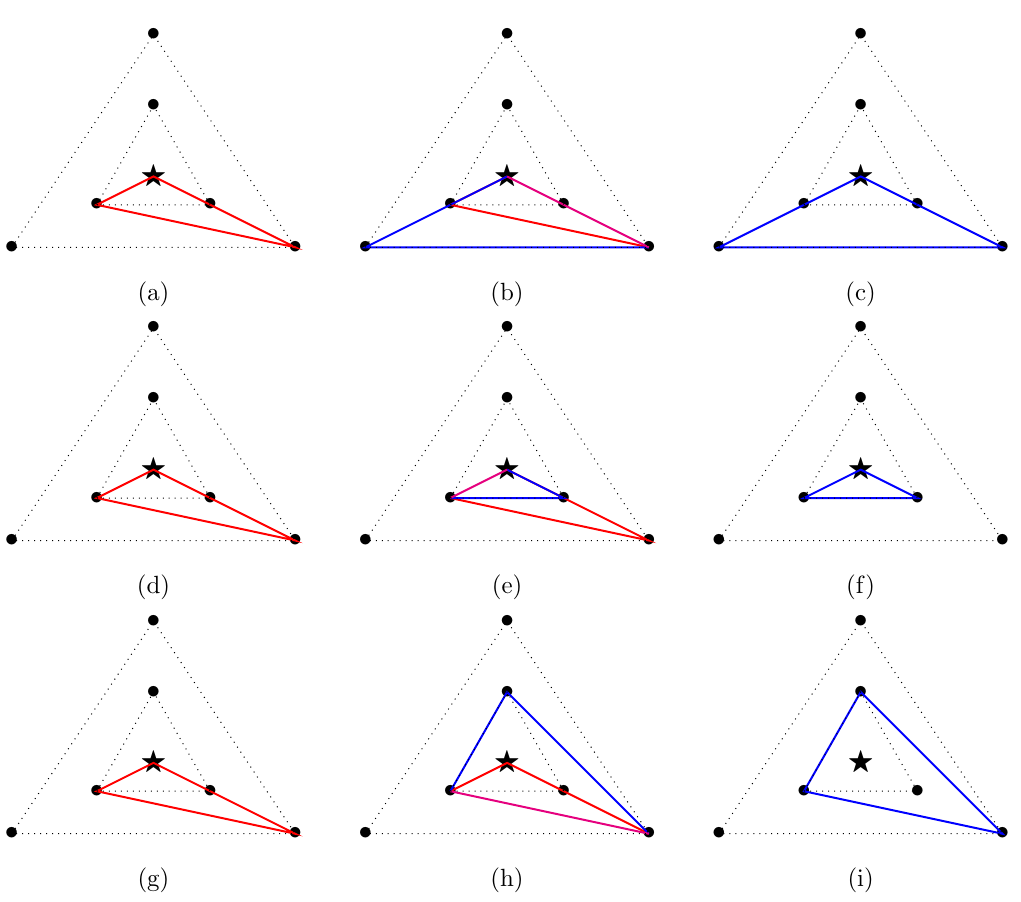
Figure 10. Continuous solutions that relate the closed ~ H + triangle solutions. The three (cid:12)gures in each row are related by an explicit one-parameter solution.